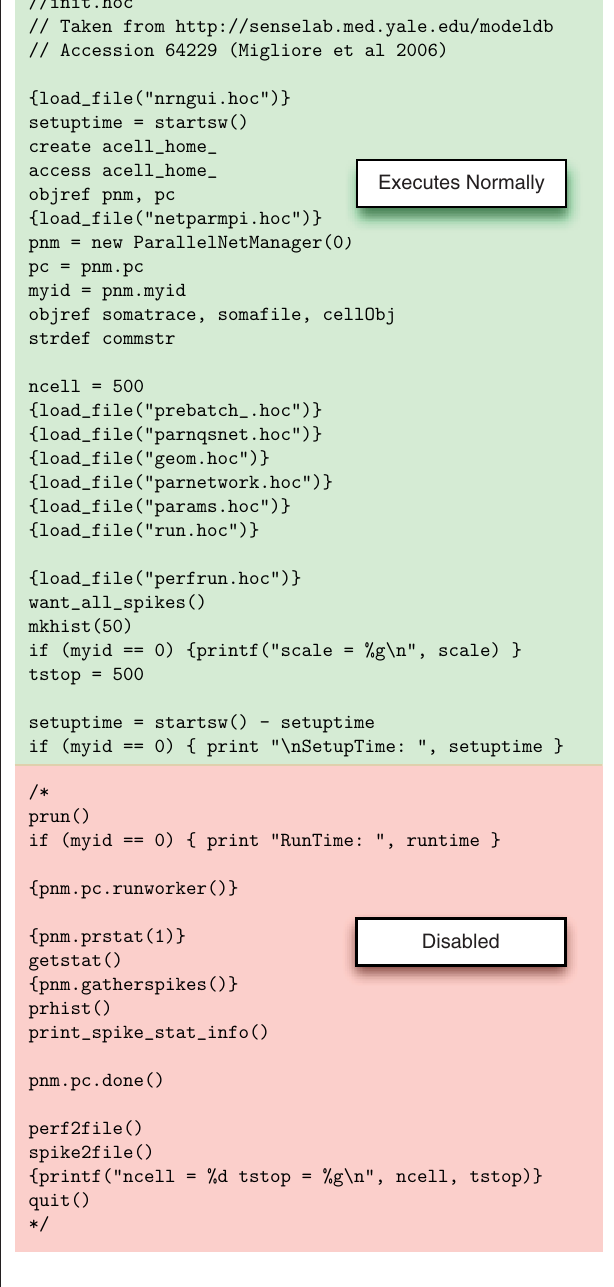
FIGURE 6 | Modifi cations to the hoc fi le from ModelDB. Setup remains normal while run is disabled to allow control to return to the Extension Framework